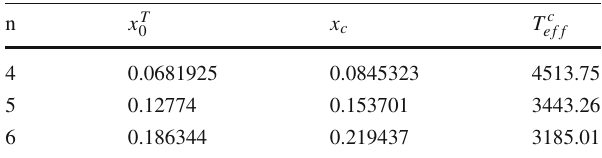
Table1 When n takesdifferentvalues,themaximumvalues T ef f under different parameters are denoted as T c corresponding x = x c , and the ef f corresponding values T ef f = 0 under different parameters are denoted as corresponding x min = x T